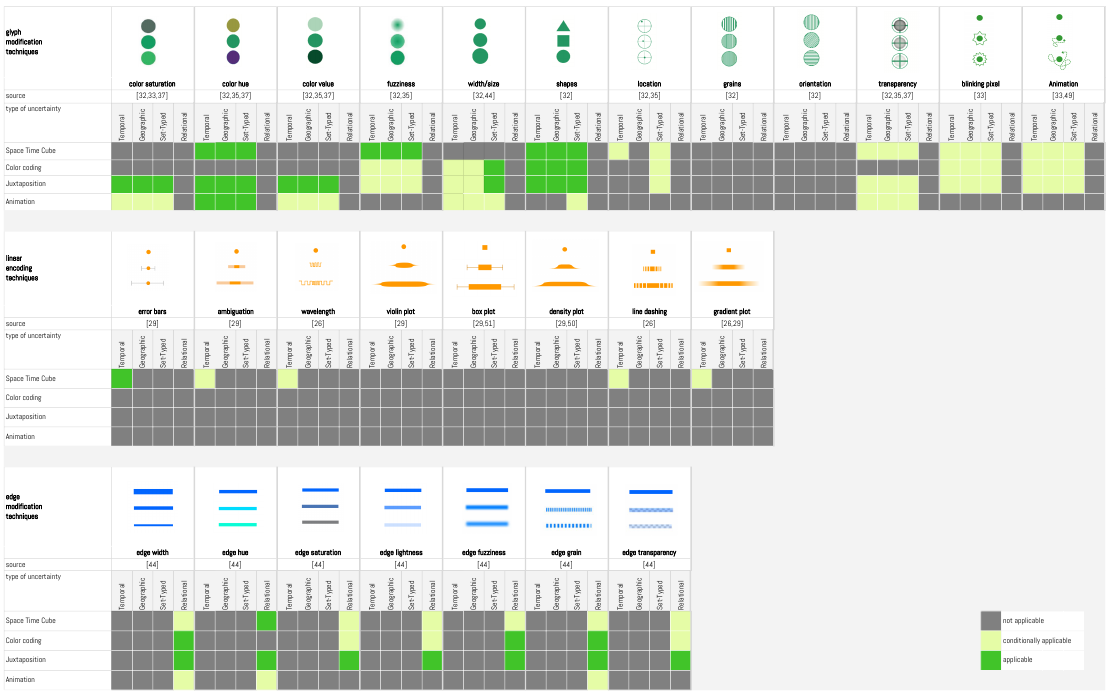
Figure 4. Visualization techniques for different dimensions of data uncertainty, making use of various strategies for glyph modification ( top ), linear encoding ( center ) and edge modification ( bottom )—assessed for their fit with the PolyCube design